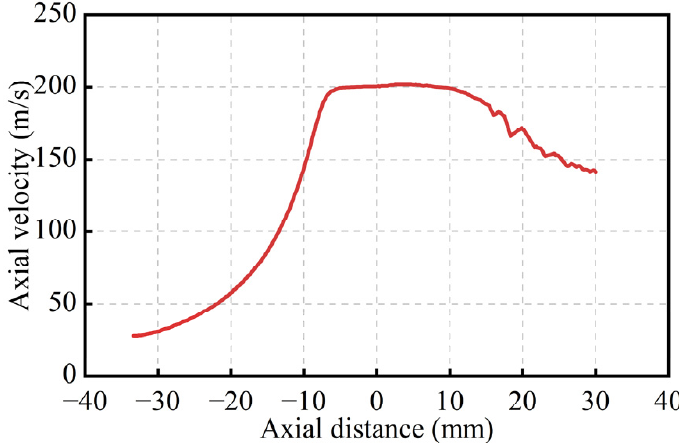
Figure 14. Axial velocity distribution.